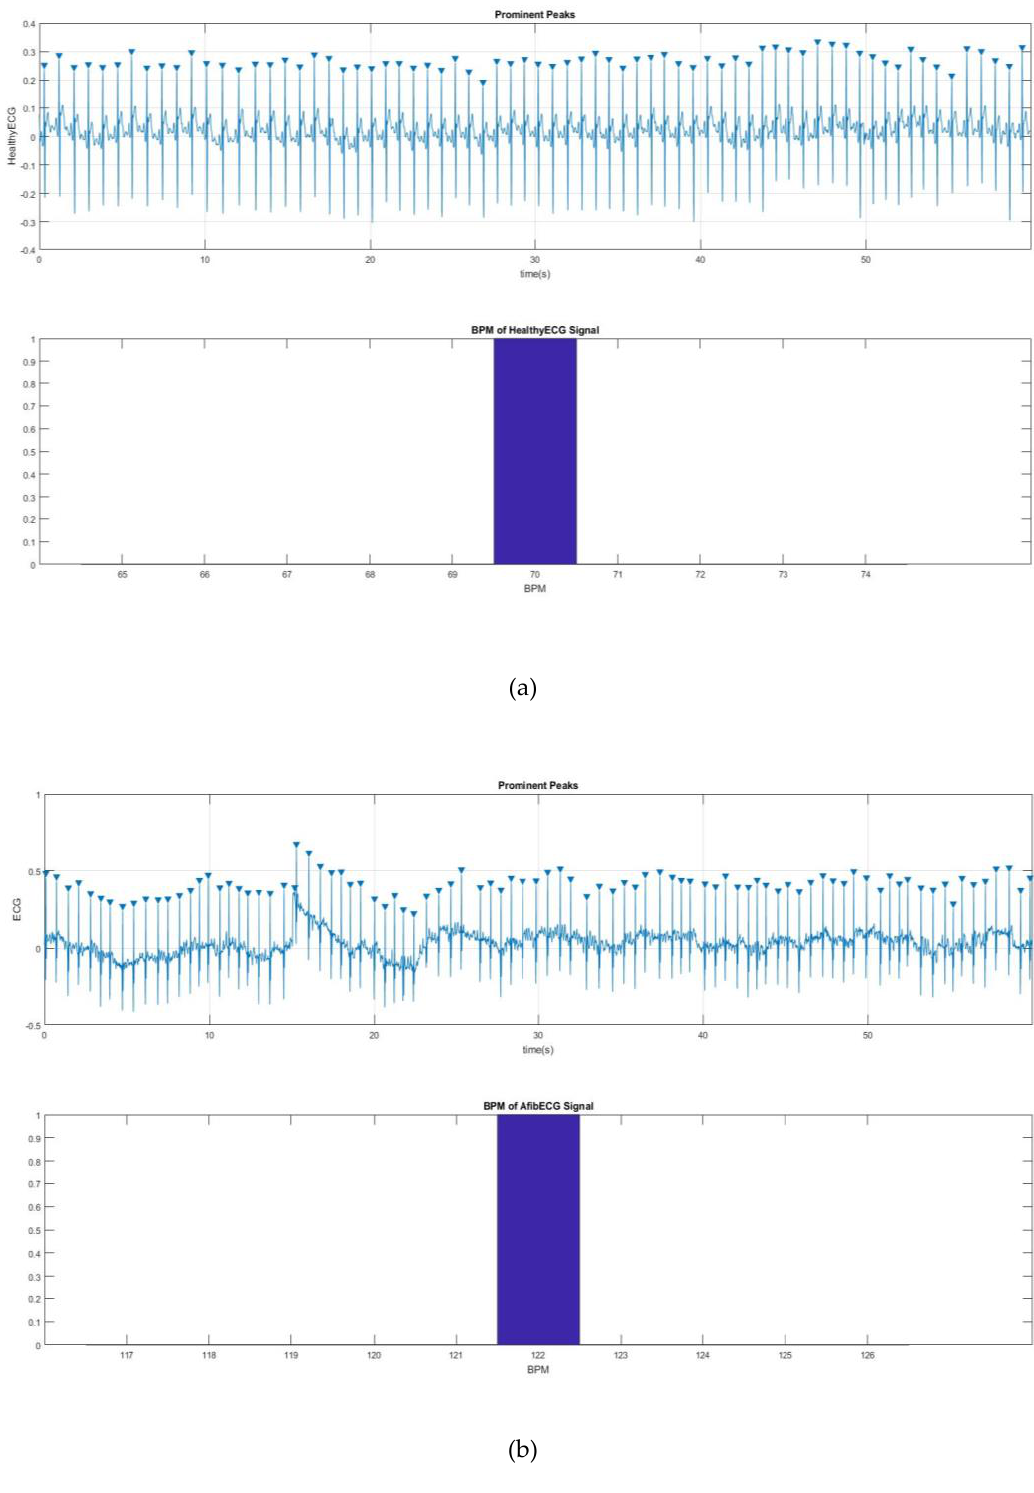
Figure 11. ( a ) 70 BPM for healthy ECG and ( b ) 122 BPM for AF ECG.